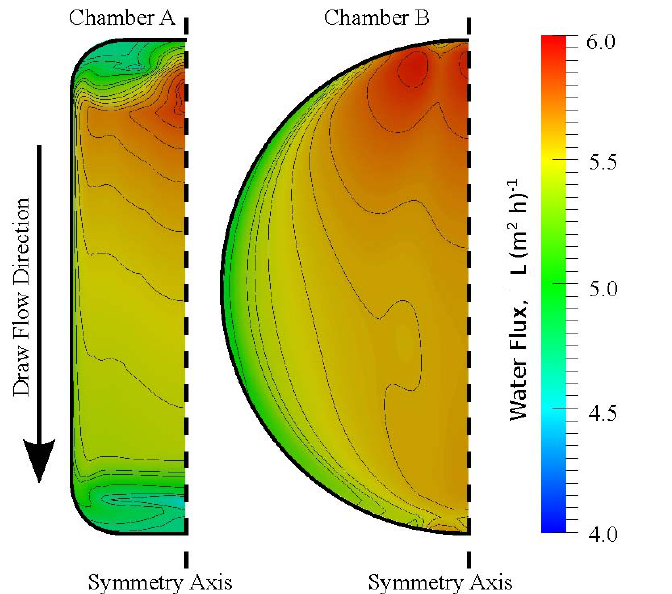
Figure 7. Spatial distribution of membrane water flux in the two chambers A and B. Inlets are at the top of the figure, and outlets are at the bottom. Both simulations were performed with 1 M draw solutions, pure water feed solutions and a cross-flow of 50 mL min − 1 . Contour lines are drawn for arbitrary scalars to guide the